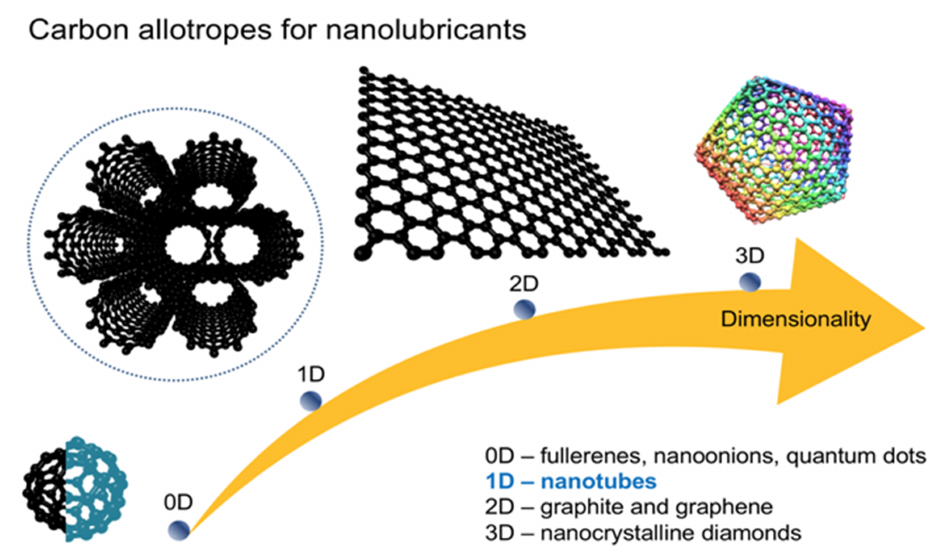
Figure 1. Overview of carbon allotropes that have so far been proposed as